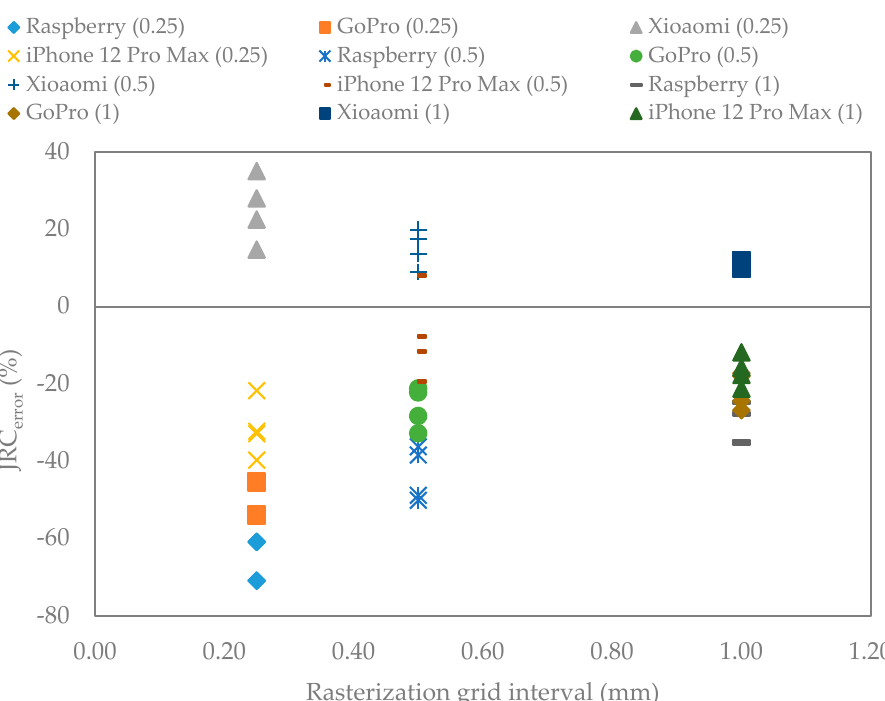
Figure 12. JRC values with different rasterization grid intervals obtained by different cameras along ‐ side the 2D profiles (L 1 to L 6 ).